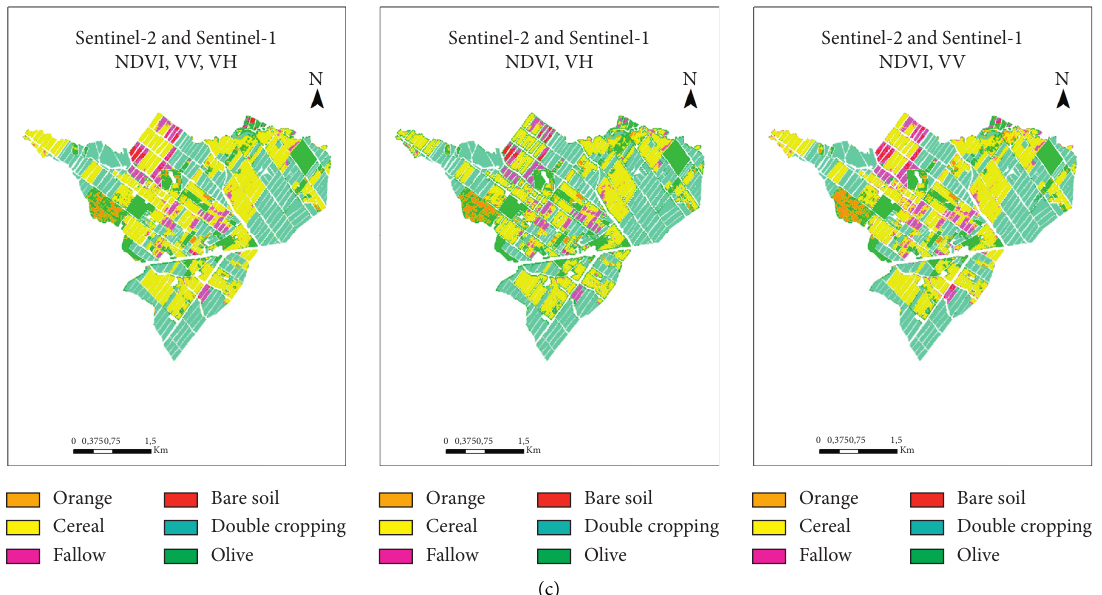
Figure 8: Classified images resulting from the best classification accuracies.